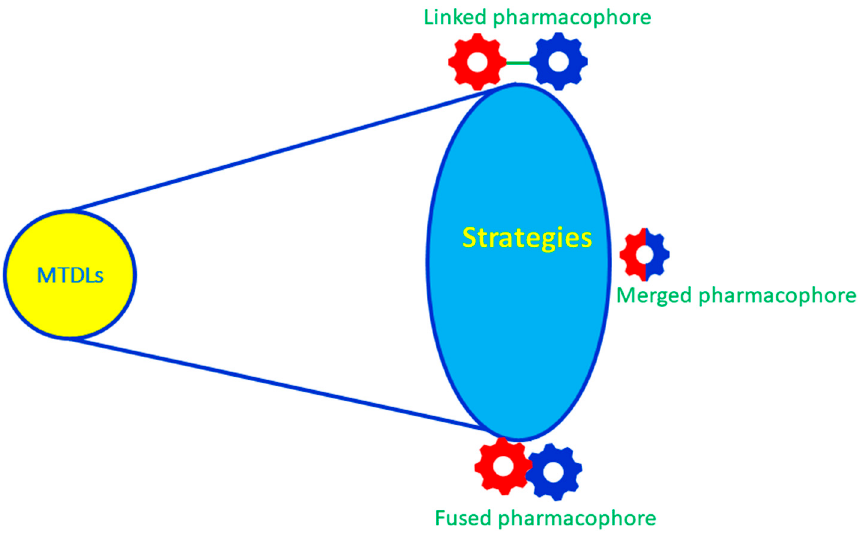
Figure 3. A schematic representation of the linked, fused and merged strategies in the MTDL de-